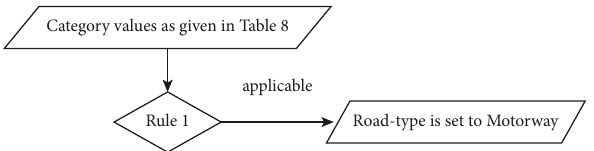
Figure 7: The steps through which the road-type decision is reached for road location shown in Figure 3.